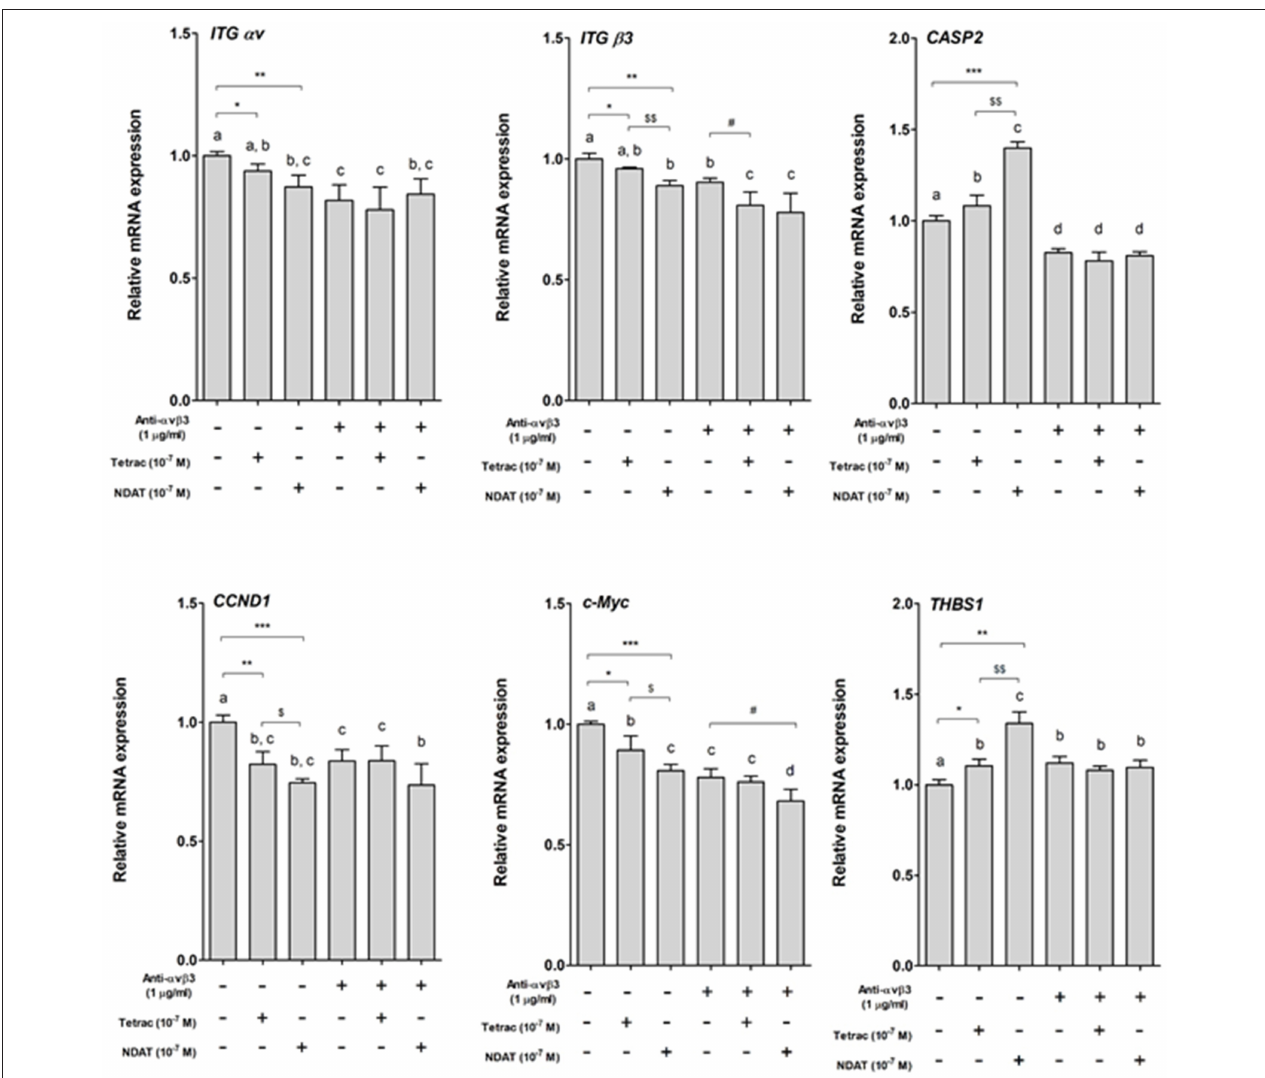
FIGURE 2 | Tetrac and NDAT via cell surface integrin α v β 3 regulate gene expression in colorectal cancer cells. HCT116 cells seeded in 6-well plates were pretreated with 1 µ g/mL of anti-integrin α v β 3 antibody for 30min and then treated with either 10 − 7 M tetrac or 10 − 7 M NDAT for 24h. Total RNA was extracted and QPCR was conducted. N = 3. (Data are expressed as mean ± SD; * p < 0.05, ** p < 0.01, *** p < 0.001, compared with untreated control; $ p < 0.05, $$ p < 0.01, compared with tetrac group; # p < 0.05, compared with anti-integrin α v β 3 antibody treatment. a–d: the subsets after post hoc analysis after the significant differences were obtained using one-way